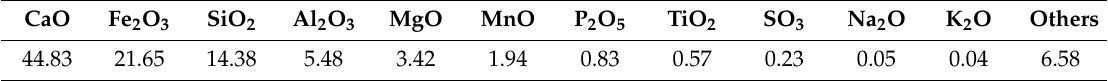
Table 3. XRF test results of steel slag powder ( wt %).